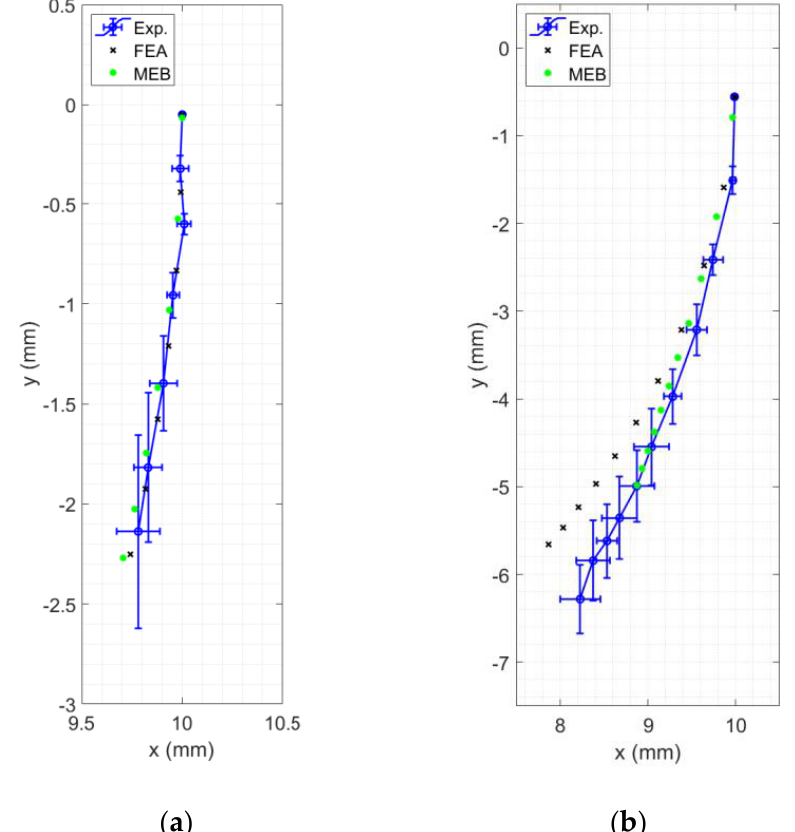
Figure 7. Comparison of experimental, FEA, and MEB deflections: ( a ) a relatively stiff Specimen 15; ( b ) a relatively flexible Specimen 1.